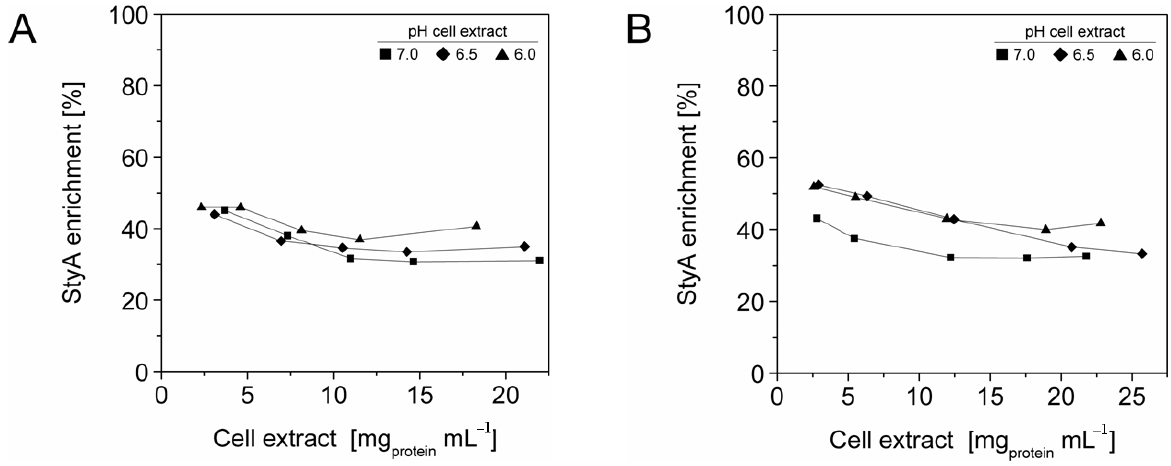
Figure 2. StyA enrichment from Escherichia coli JM101 (pSPZ10) cell extract at various pH values on ( A ) Sepabeads EC-EA and ( B ) Sepabeads EC-Q1A. StyA enrichments reflect the fraction of adsorbed StyA over totally adsorbed Escherichia coli JM101 cell extract proteins at binding equilibrium.